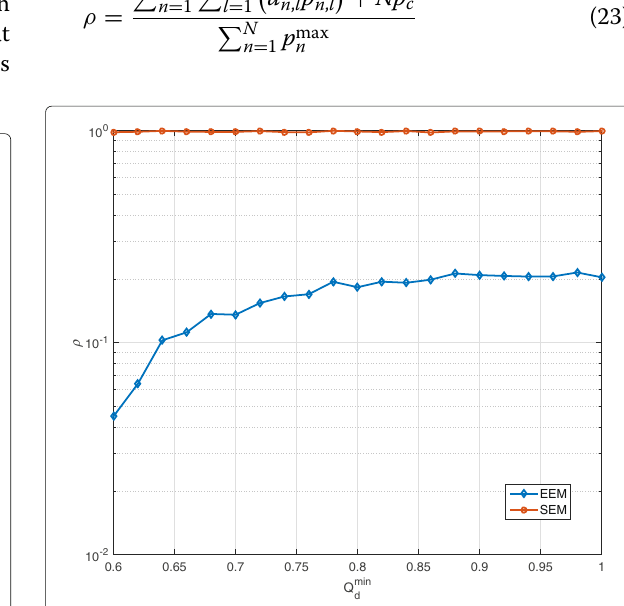
Fig. 4 Spectrum efficiency comparison